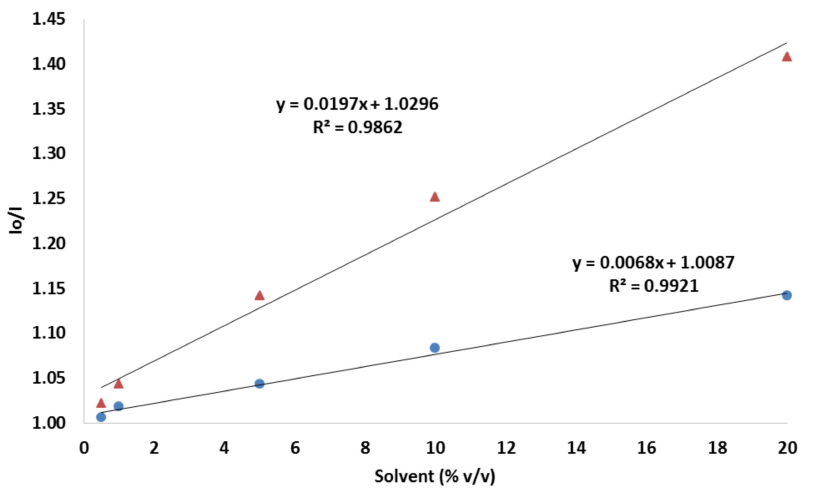
Figure 7. Calibration curve for acetic acid (orange triangle) and ethanol (blue dot) using a test paper with compound 2